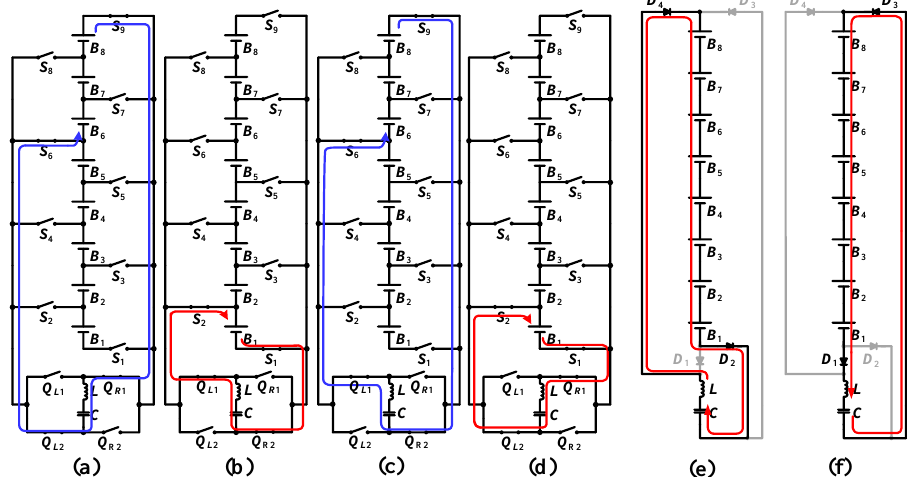
Figure 3. Operating states and current flow of the proposed equalizer at V BR = V B8 + V B7 + V B6 and V BC = V B1 . ( a ) State I: positive collect. ( b ) State II: positive release. ( c ) State III: negative collect. ( d ) State IV: negative release. ( e ) Positive afterproduction. ( f ) Negative afterproduction.